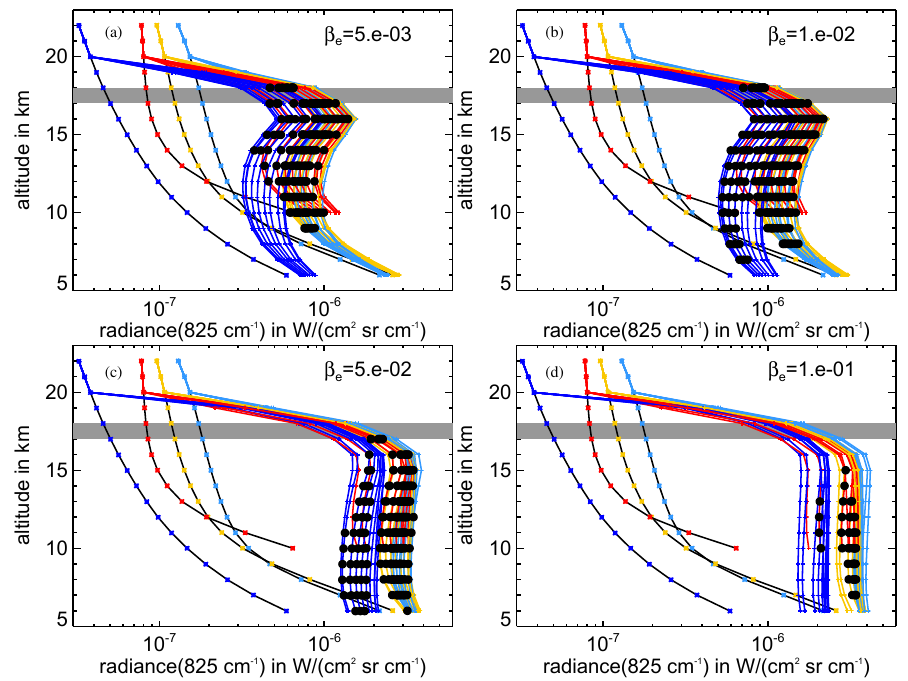
Figure 12. Simulated radiances for ash layers between 17 and 18km with extinction coefficients of 5 × 10 − 3 km − 1 , 1 × 10 − 2 km − 1 , 5 × 10 − 2 km − 1 and 1 × 10 − 1 km − 1 . The black dots mark the tangent altitudes where the ash detection threshold is exceeded. The black profiles are the clear air simulations for polar winter (blue), polar summer (light blue), mid-latitude (yellow) and equatorial (red) atmosphere.